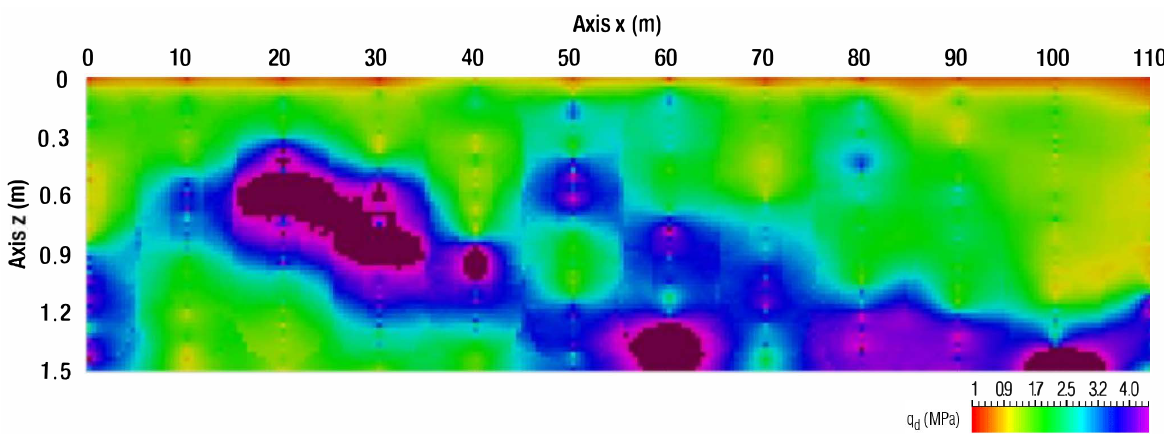
Figure 10. OK estimation of q d . xz-plane longitudinal profile. Survey grid: First third, near the embankment dam